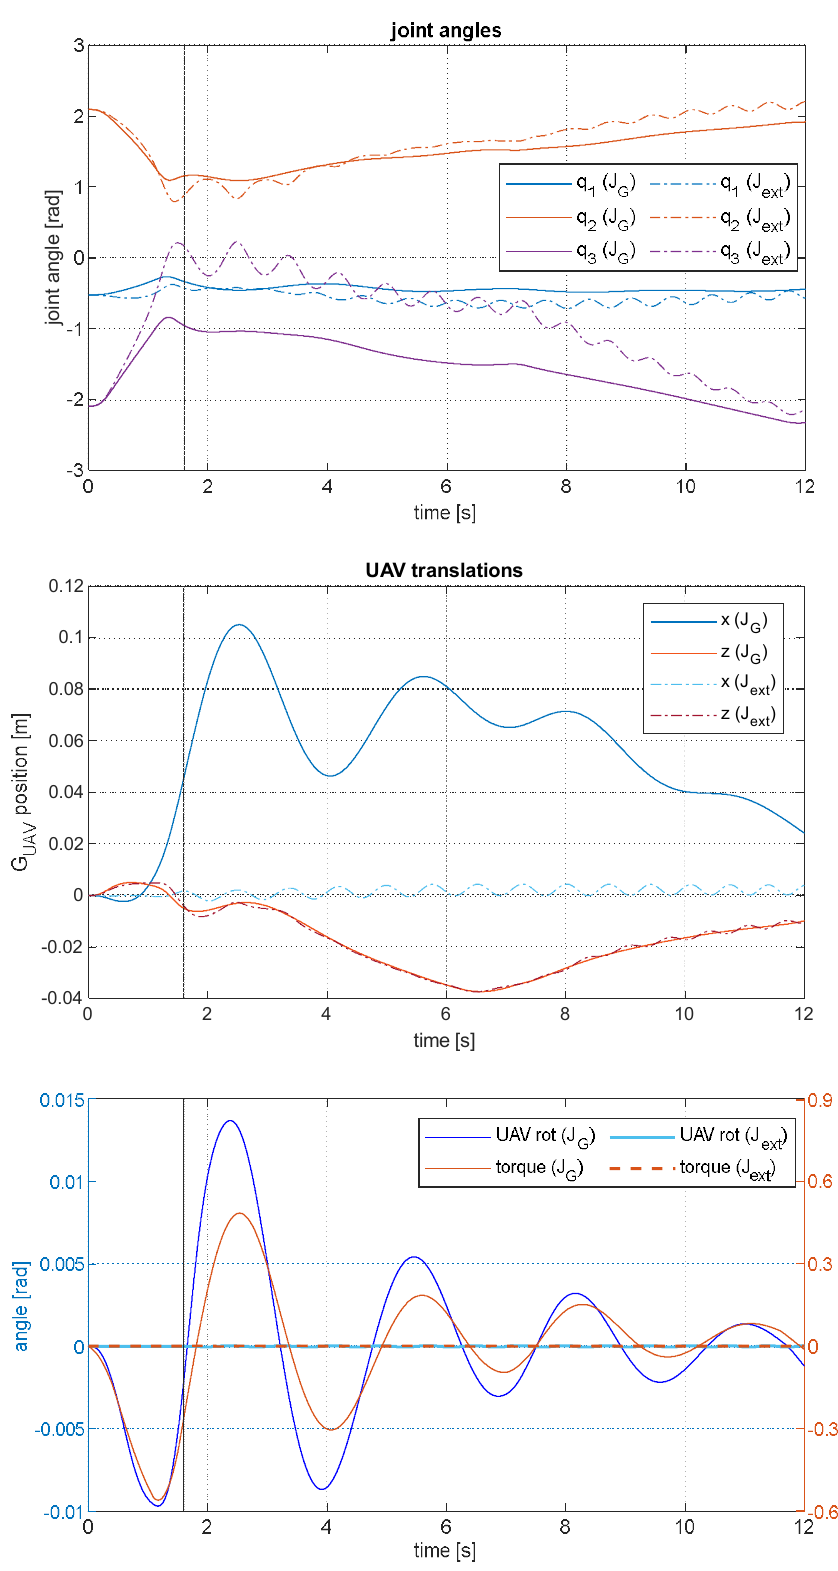
Figure 23. Comparison between generalized Jacobian with external forces (J G ) and extended generalized Jacobian (J ext ) solutions for the 3-DOF redundant UAM: manipulator motions ( top ), UAV translations ( middle ), UAV rotation and torque disturbance from the manipulator to the UAV ( bottom ). The vertical dark line indicates the start time of contact for the grasp.